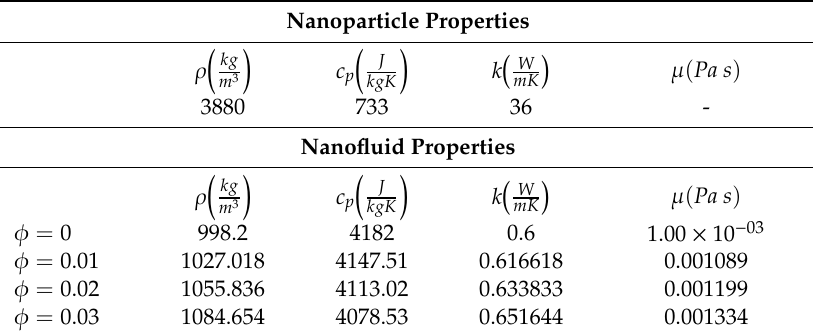
Table 1. Water–Al 2 O 3 nanofluid thermo-physical